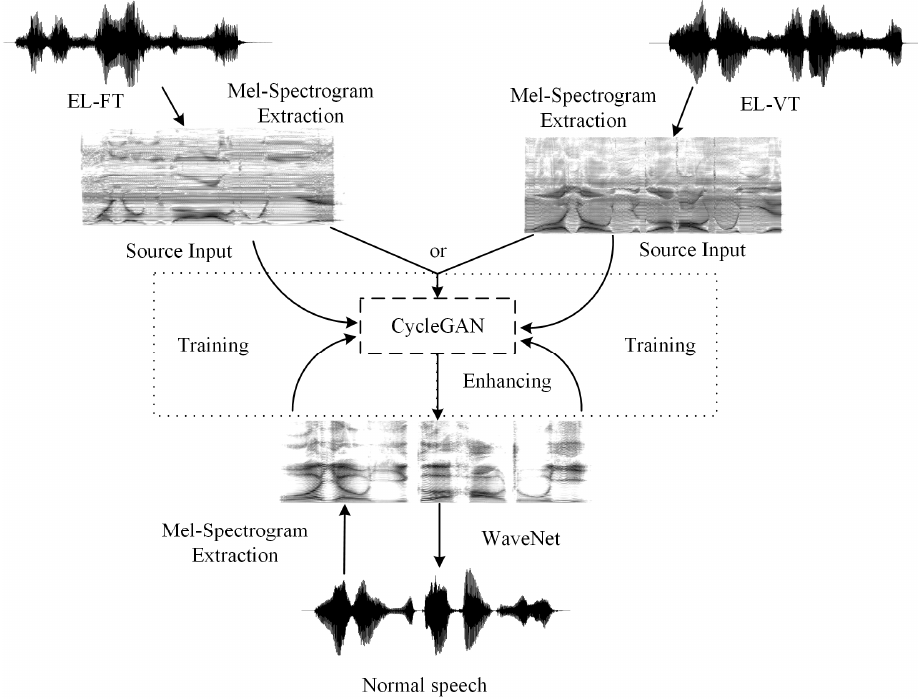
Figure 1 . Procedure for enhancing Mandarin EL speech using CycleGAN and